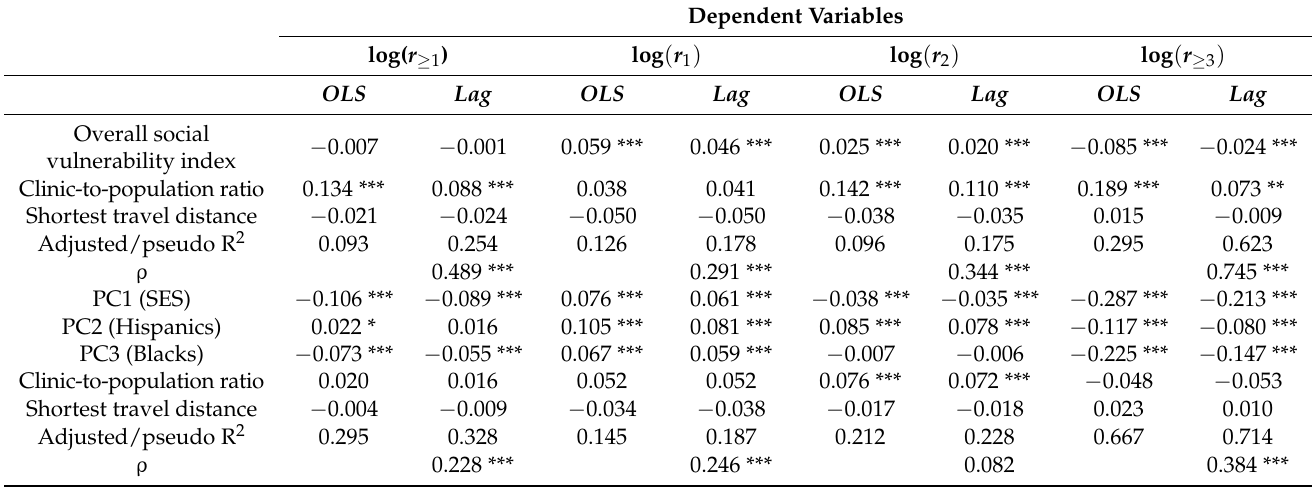
Table 3. Results of OLS and spatial-lag models of the vaccination rates by social vulnerability and spatial